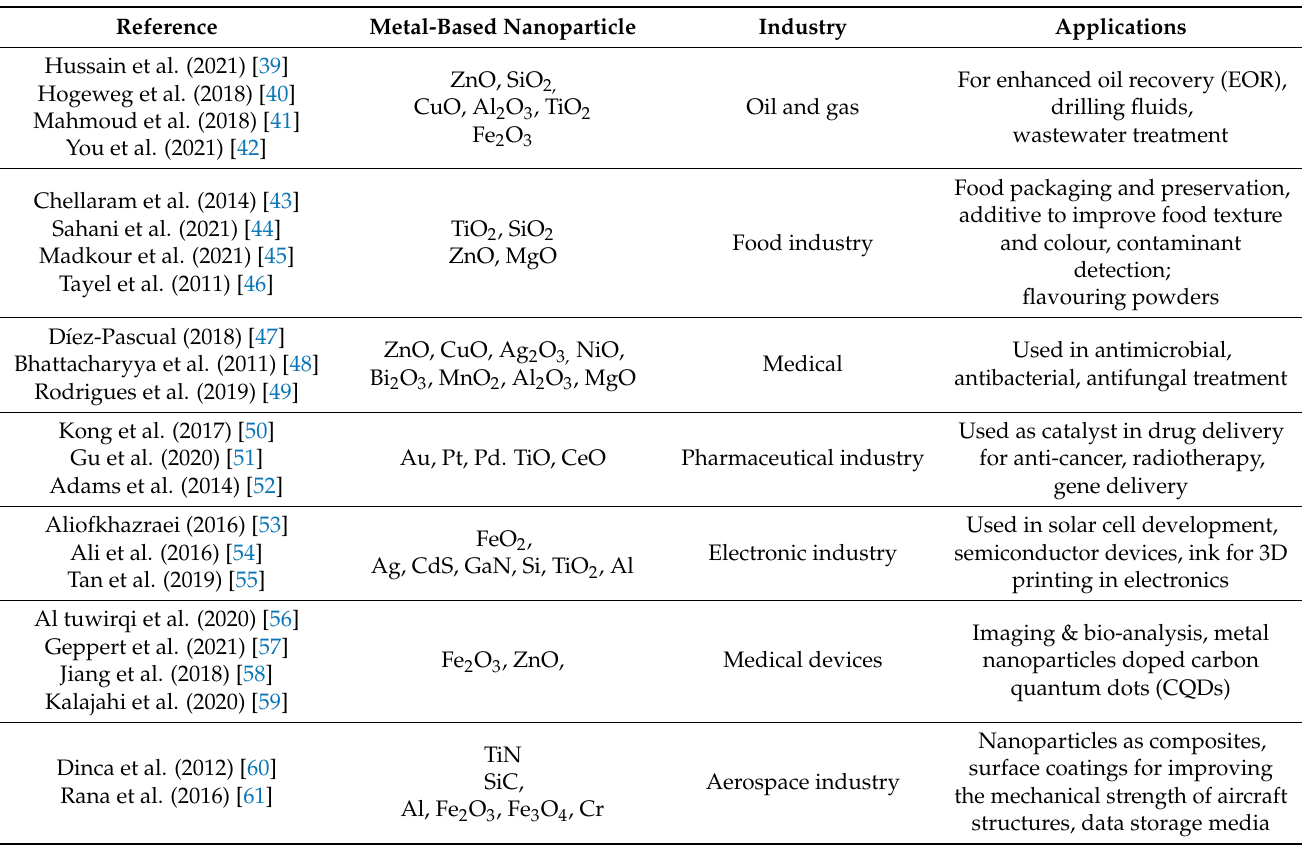
Table 1. Applications of various metal-based nanoparticles used in various industrial